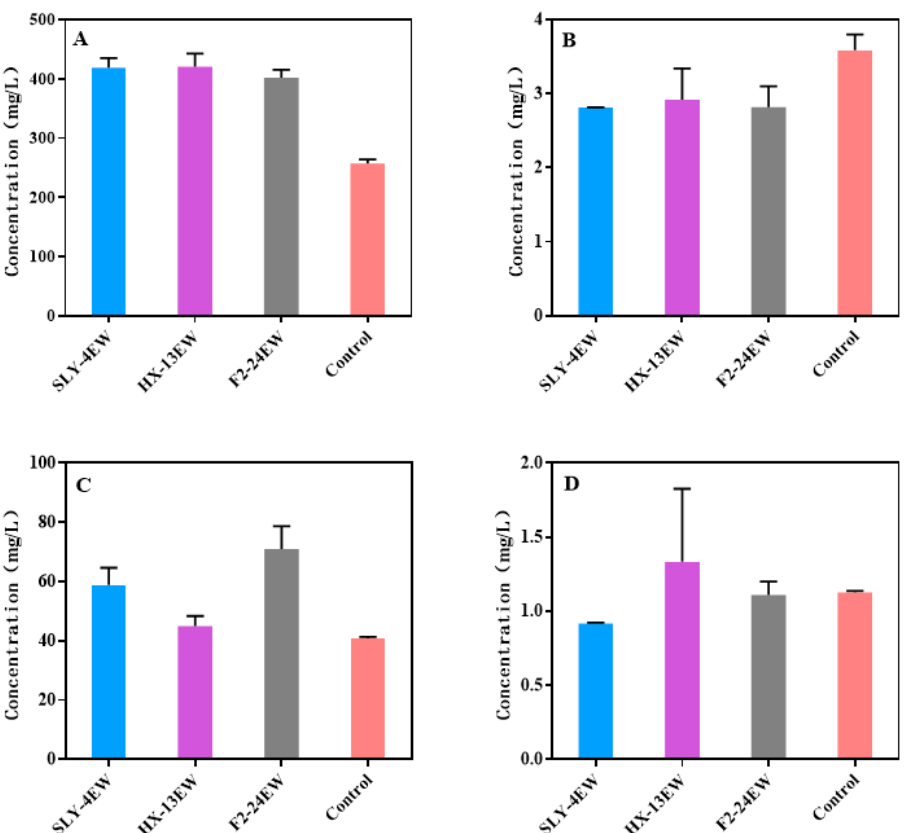
Figure 3. Concentration of fermentation aroma components from wines. ( A ) Higher alcohols; ( B ) Fatty acids; ( C) Esters; ( D ) Carbonyl compounds .